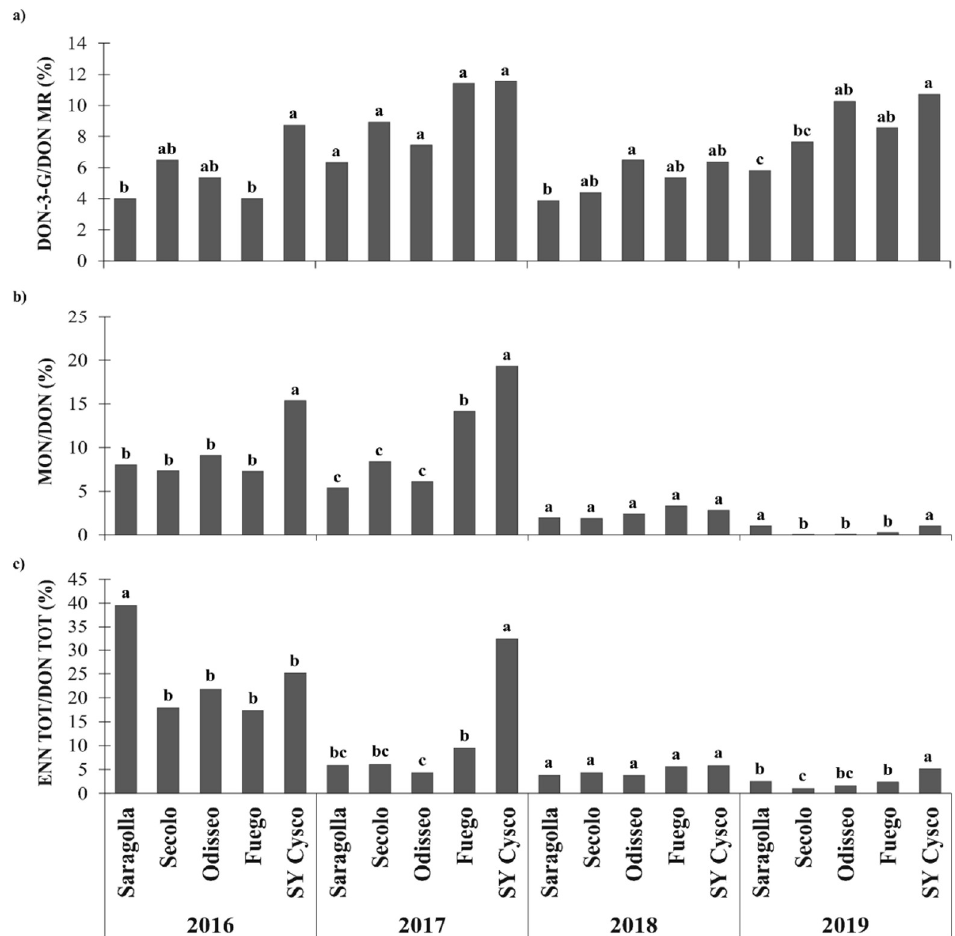
Figure 4. Effects of the growing season and durum wheat cultivar with different degrees of FHB susceptibility on the mycotoxin content ratios in NW Italy during the 2015–2019 period: ( a ) Deoxynivalenol-3-glucoside/deoxynivalenol molar ratio (DON-3-G/DON MR); ( b ) Moniliformin/Deoxynivalenol content ratio (MON/DON); ( c ) Total enniatin/Total deoxynivalenol content ratio (ENN TOT/DON TOT: ENN TOT = sum of enniatin A, ENN A; enniatin A 1 , ENN A 1 ; enniatin B, ENN B; and enniatin B 1 , ENN B 1 ; DON TOT = sum of deoxynivalenol, DON; deoxynivalenol-3-glucoside, DON-3-G; and 3-acetyldeoxynivalenol, 3-ADON). Different letters above the bars indicate significant differences between cultivars for each growing season ( p < 0.05). The reported data are the average of 3